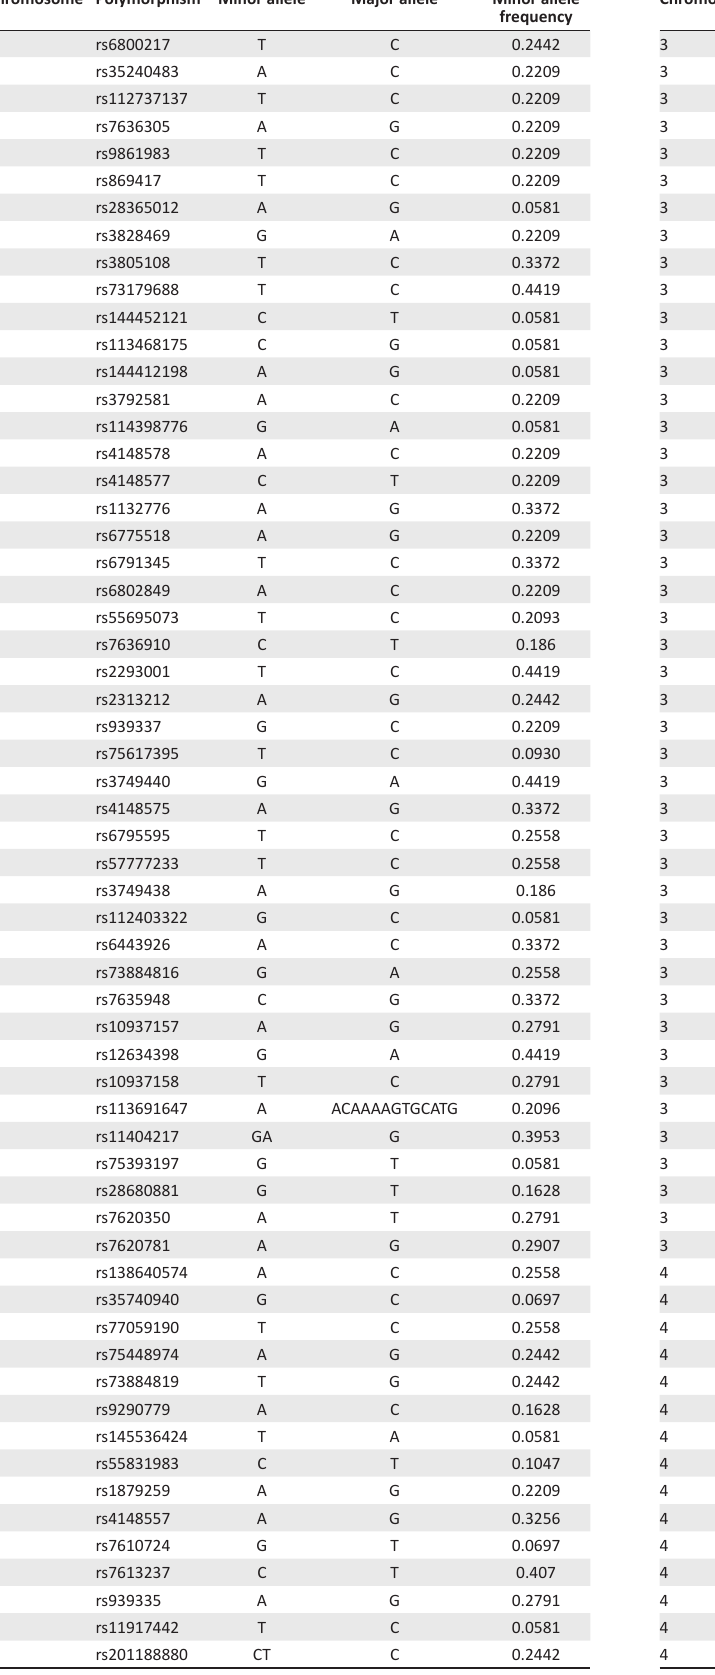
Table 1-A1 continues on the next page →Table 1-A1 continues in the next column